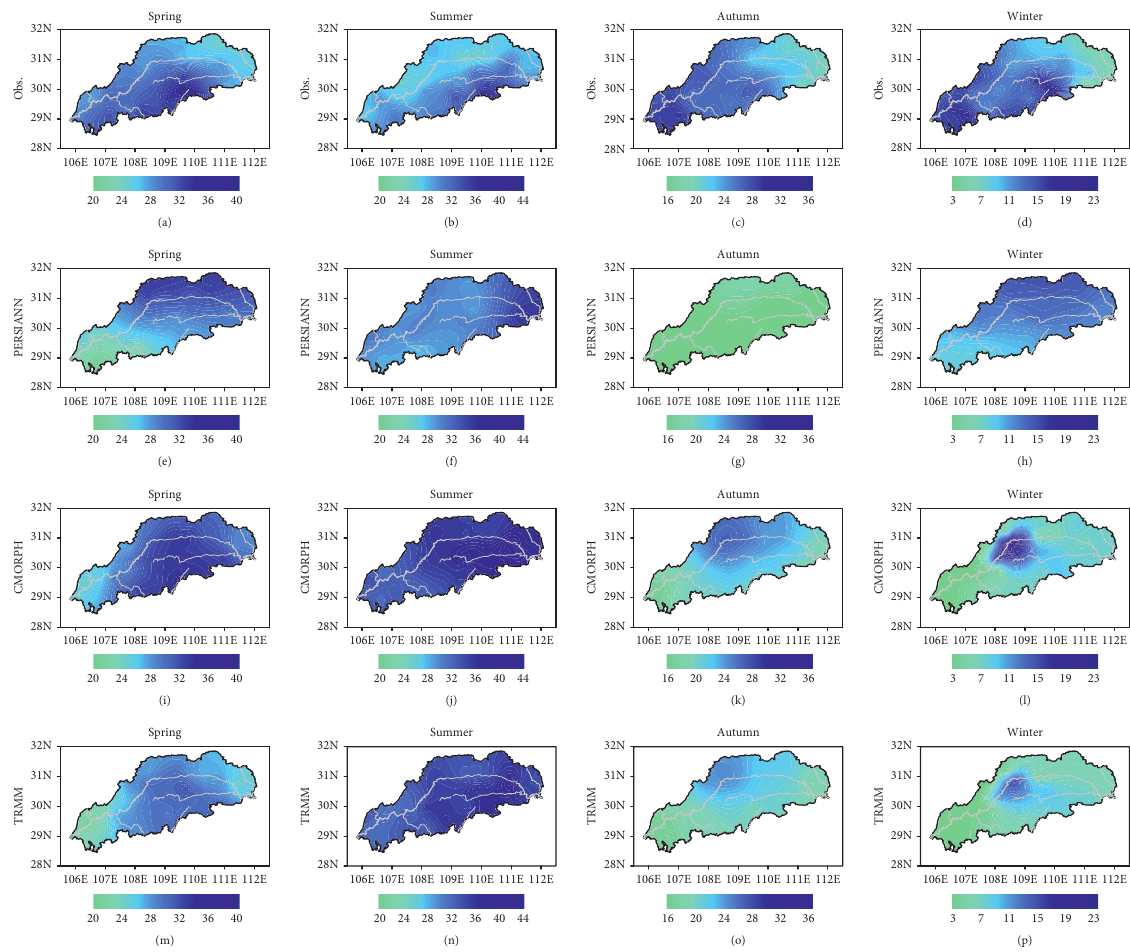
Figure 18: The spatial distribution of seasonal mean rainy day (based on the rainfall amount greater than or equal to 1mm) in (a–d) gauge observation, (e–h) PERSIANN, (i–l) CMORPH, and (m–p)